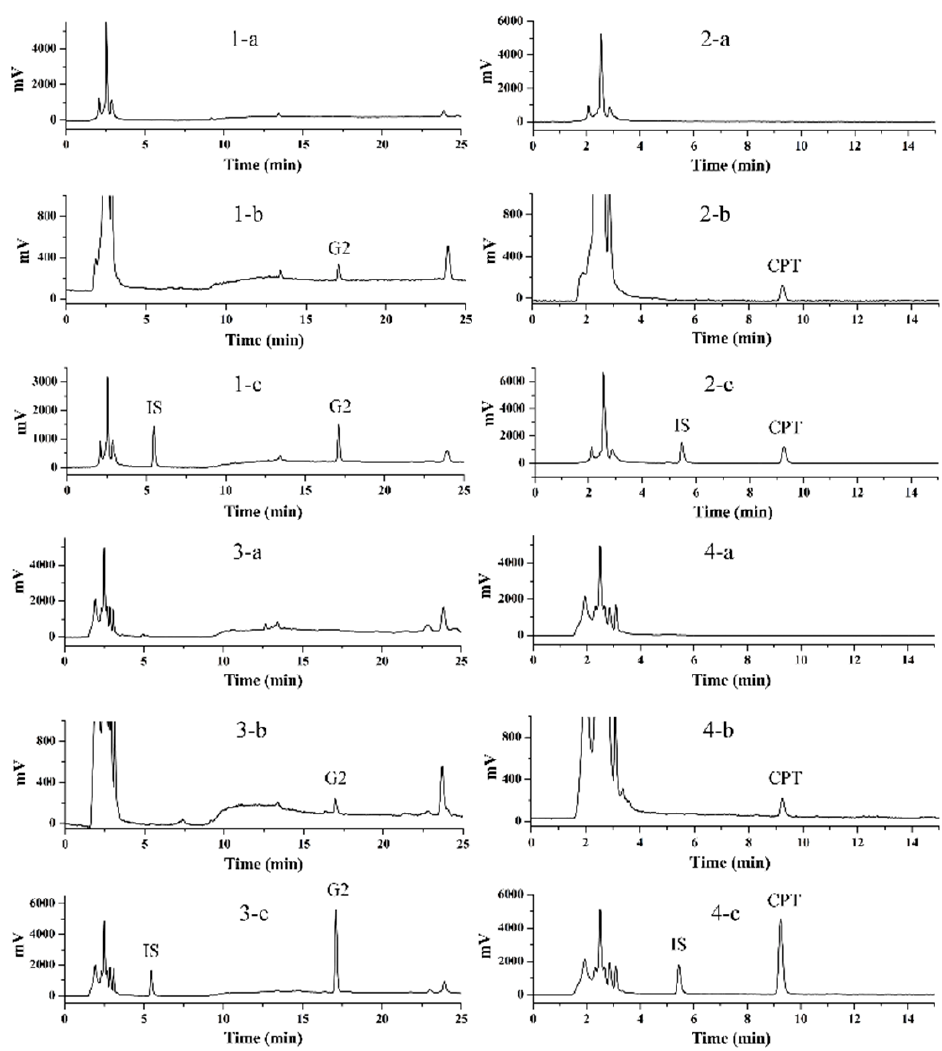
Figure 6. Chromatograms of plasma (1, 2) and liver homogenate (3, 4) samples: ( a ) blank sample; ( b ) blank sample spiked with 0.030 µ M G2 or CPT; ( c ) plasma or liver homogenate sample after oral administration 0.5 h and spiked with